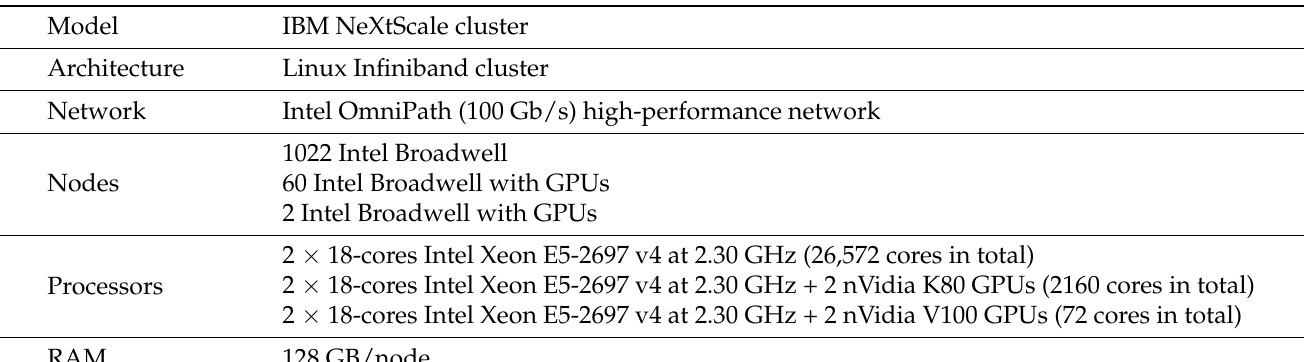
Table 1. Main features of the GALILEO HPC